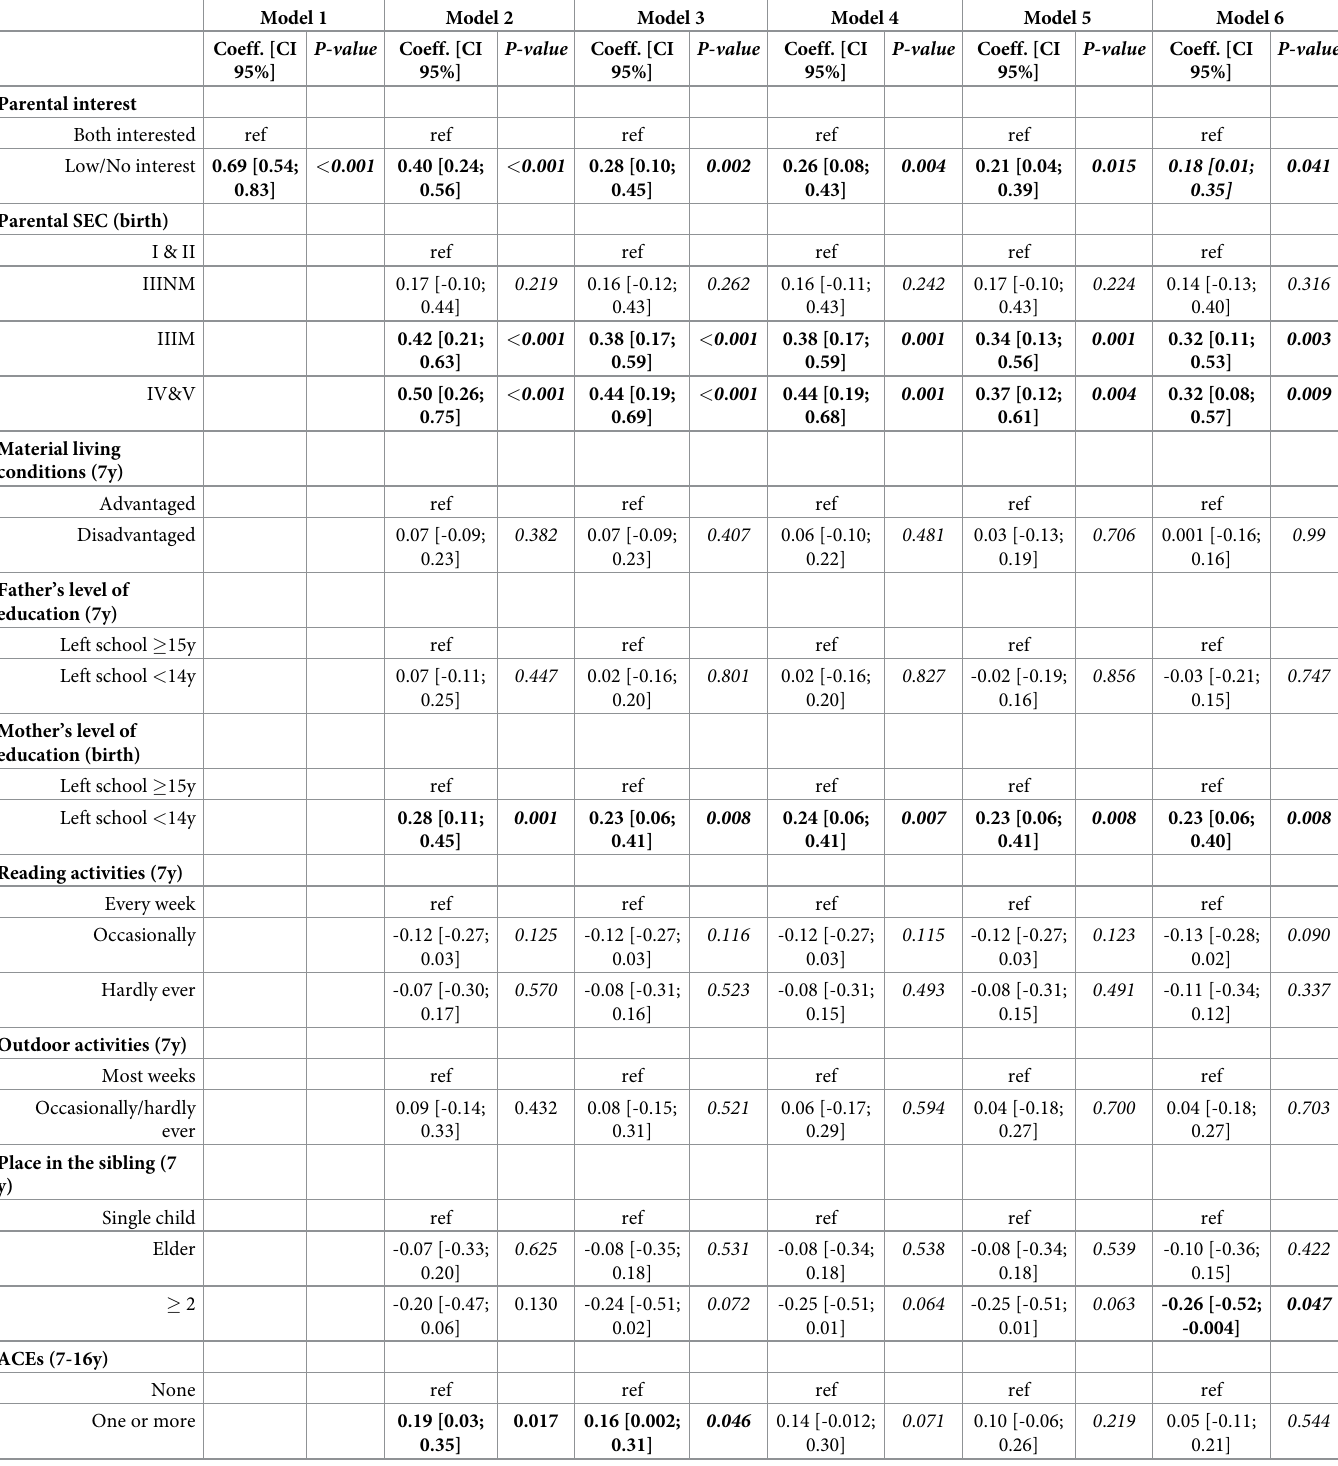
Table 4. Life course multivariable linear regression between allostatic load and parental interest using data obtained from multiple imputation for women (n = 4